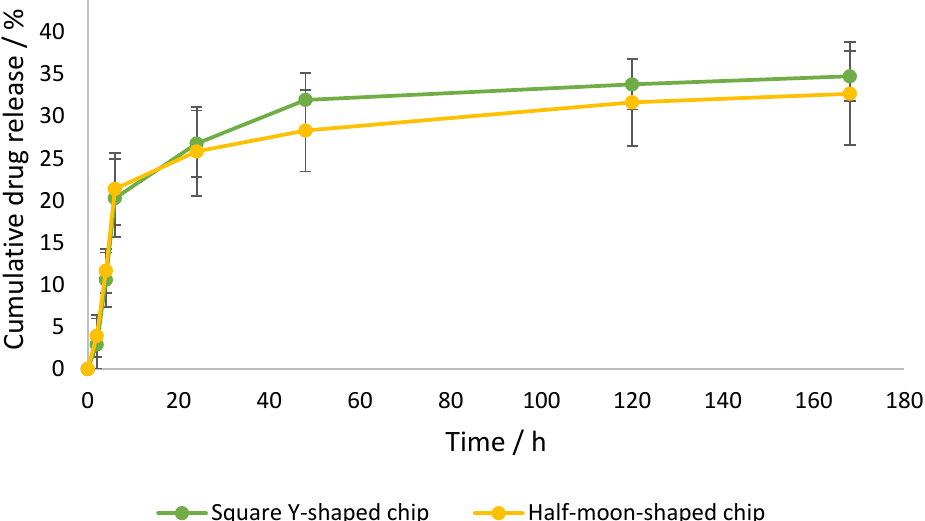
Figure 8. Cumulative curcumin release over time from liposomes formulated by square Y-shaped and half-moon-shaped chips, with a maximum release of 35%.